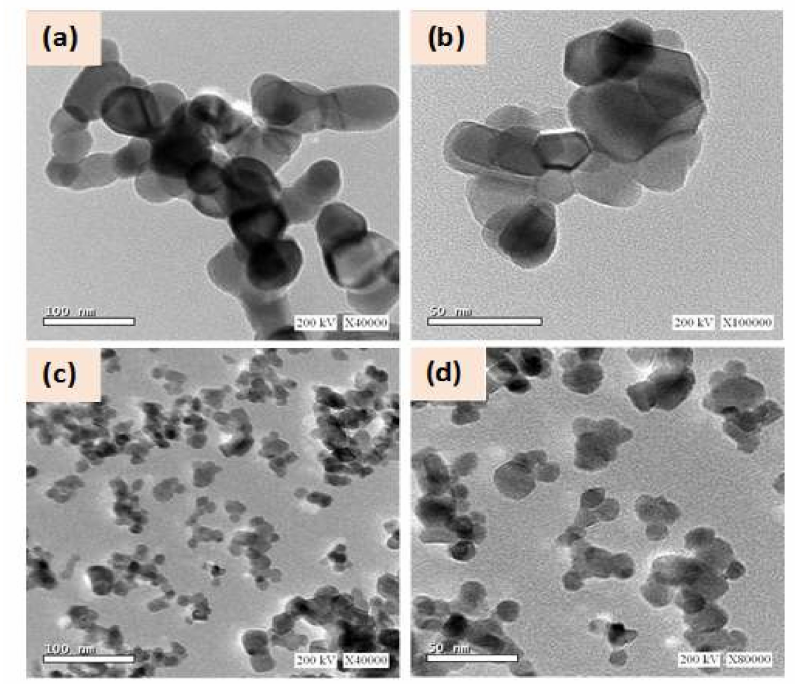
Figure 4. HRTEM micrographs for the investigated Ga-doped ZnO; ( a , b ) for GZO-0 and ( c , d ) for